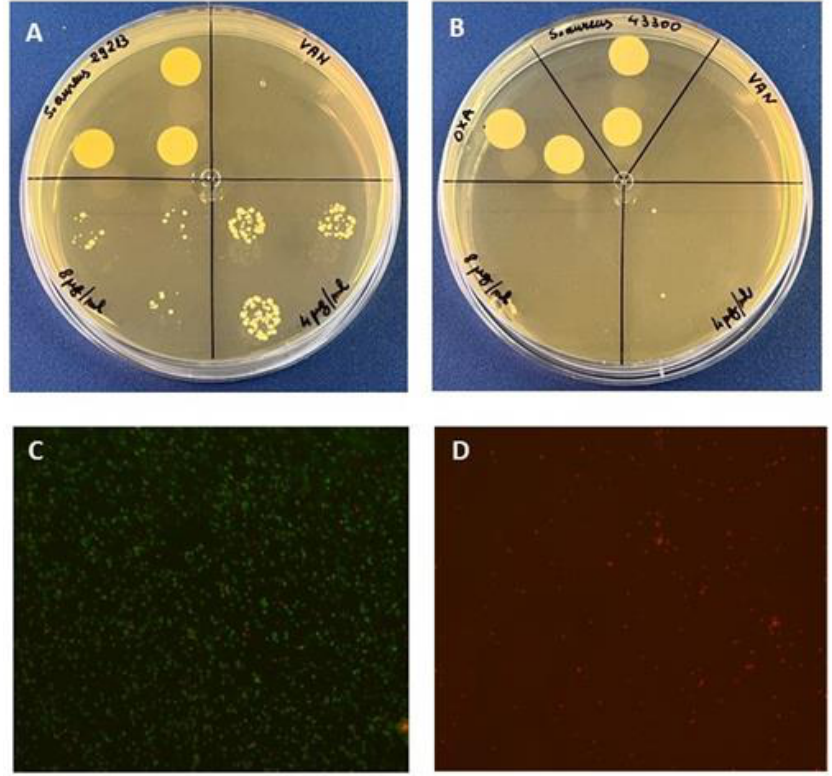
Figure 3 . Bactericidal activity of MC_A3 (panels A-B). Representative pictures of Live/dead imaging of S. aureus MRSA after 4 m g/ml MC_A3 treatment (panels C-D). Cells were observed at × 20 magnification (Iris Digita System, Twin Helix). After 24 h, control cells showed uptake of only acridine orange (C) (green fluorescence) while MC_A3-treated cells showed uptake of ethidium bromide (D) (red fluorescence).